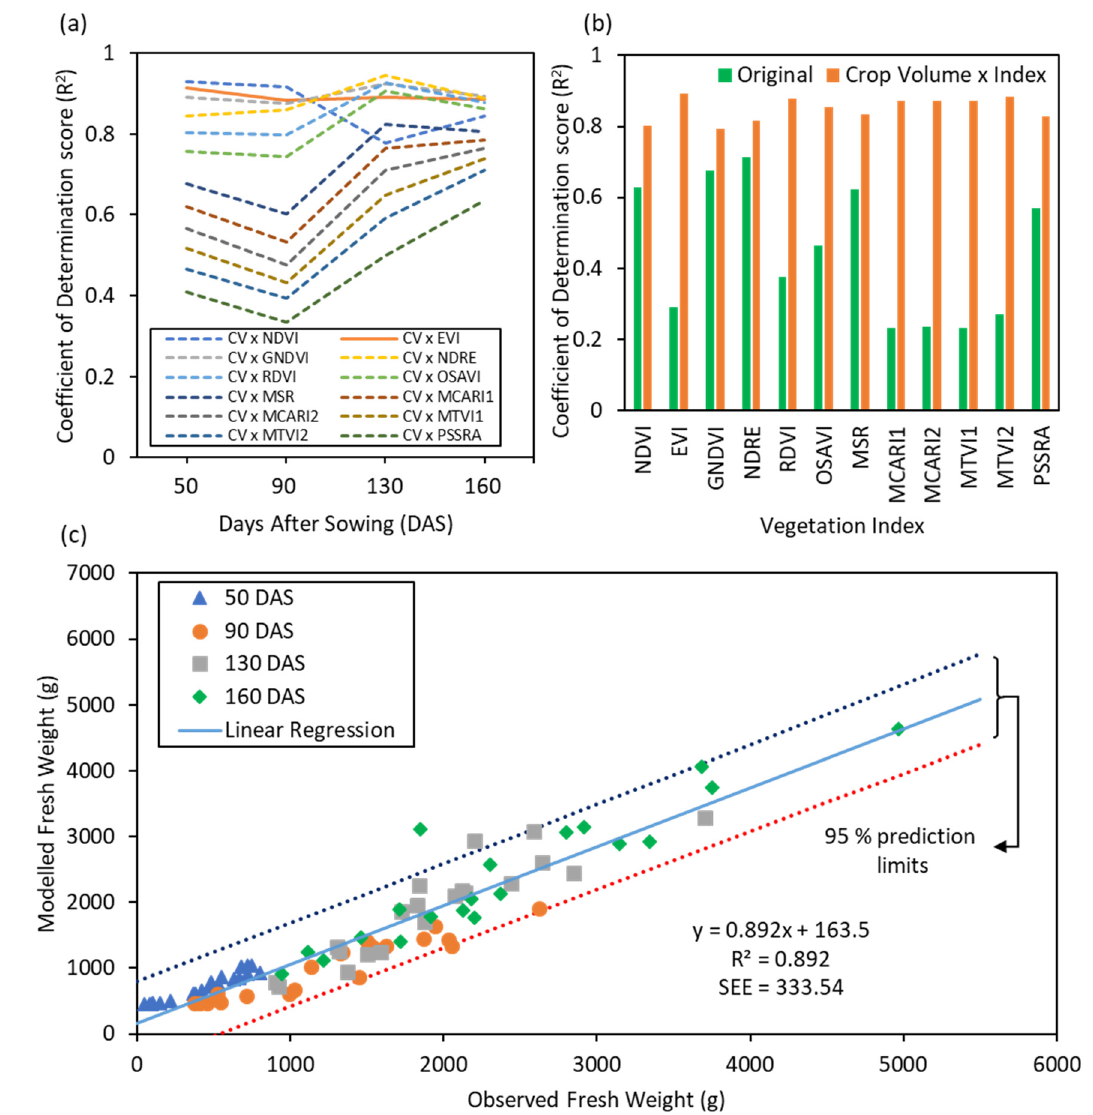
Figure 6. Estimation of fresh biomass or fresh weight (FW): Variability in the correlation of determination (R 2 ) of crop volume multiplied using standard vegetation indices (CV × VIs) ( a ) across di ff erent time points and ( b ) at all the time points combined against observed FW; ( c ) Modelling results for FW derived from CV × EVI against observed FW